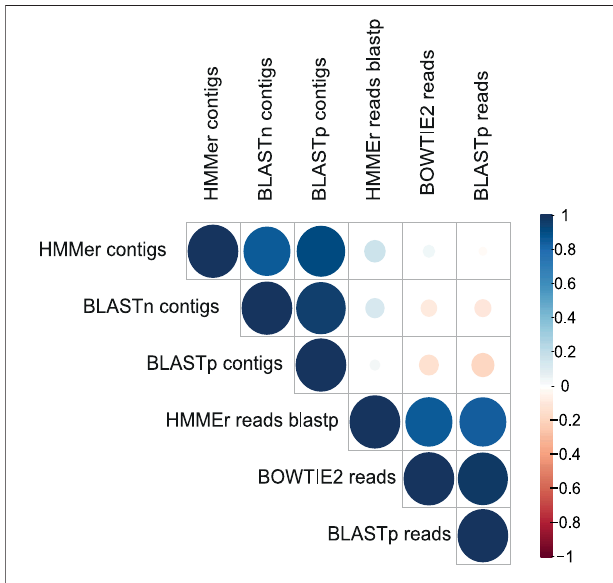
FIGURE 8 | Proportion of contigs obtained related to viral proteins in each environmental metagenome. The colors allow to identify in the horizontal bars the rate of sequences related to viral proteins ( x -axis) according to the viral family ( y -axis) in each environmental